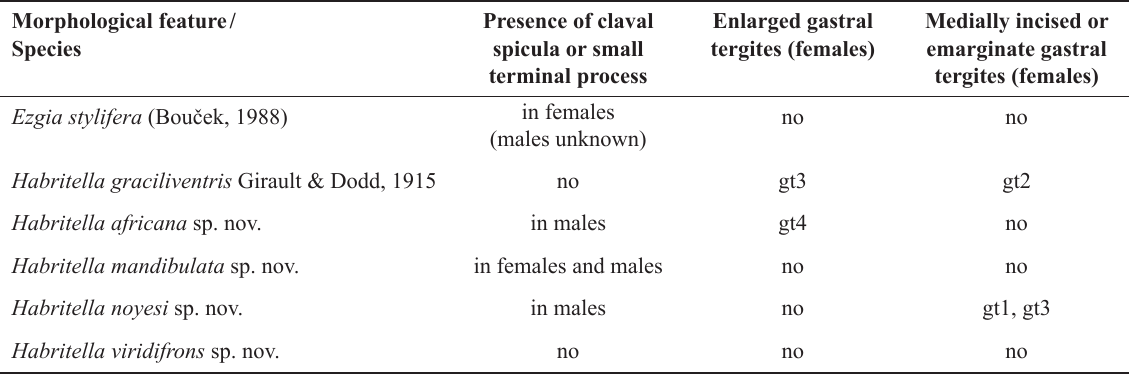
Table 1. Comparison among previously described species of Ezgia Koçak & Kemal, 2008 and Habritella Girault & Dodd, 1915 and the new